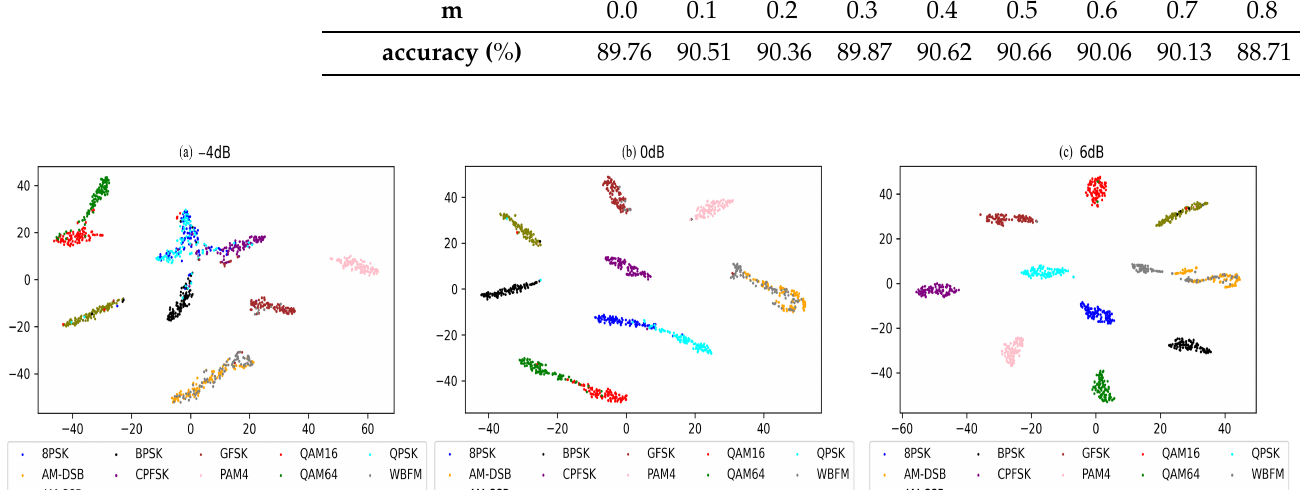
Figure 9. The distribution of features extracted at the penultimate layer for different SNRs. ( a ) The distribution of features extracted at the penultimate layer for an SNR of − 4 dB. ( b ) The distribution of features extracted at the penultimate layer for an SNR of 0 dB. ( c ) The distribution of features extracted at the penultimate layer for an SNR of 6